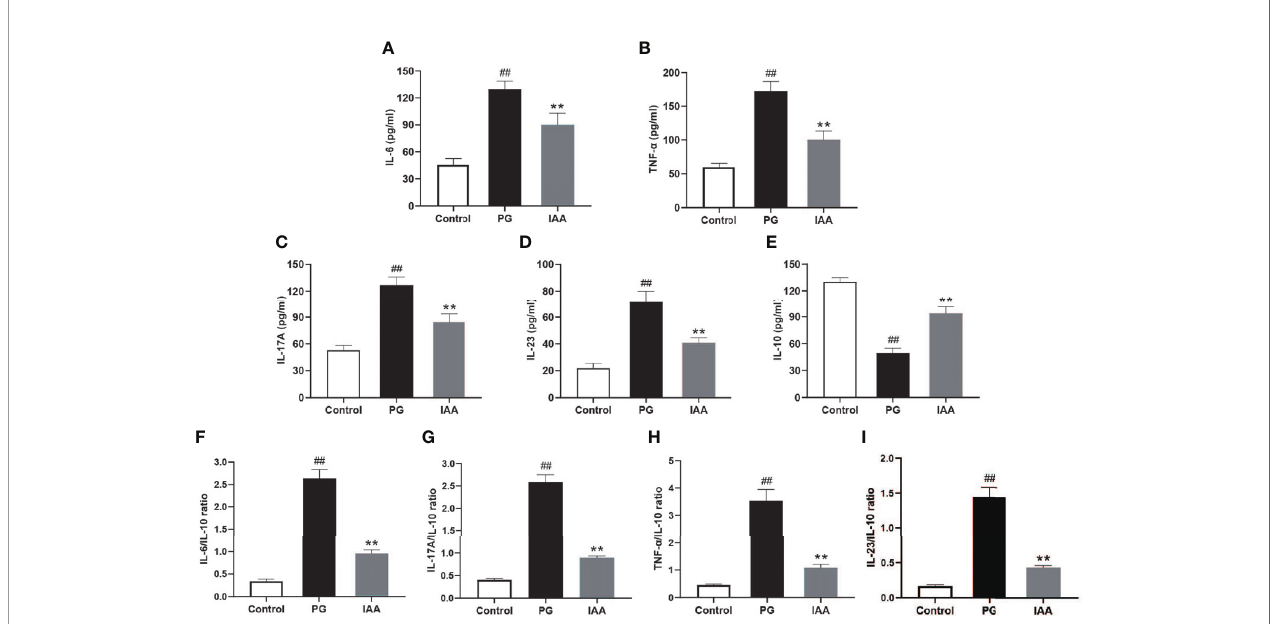
FIGURE 2 | IAA inhibits pro-in fl ammatory cytokines expressions, elevates anti-in fl ammatory cytokine expression, and reduces the ratios of pro-/anti- in fl ammatory cytokines in AS mice. Ankylosing spondylitis (AS) mice were administered intraperitoneal injections of indole-3 acetic acid (IAA; 50 mg/kg/day) for 4 weeks. The serum levels of the pro-in fl ammatory cytokines interleukin (IL)-6, tumor necrosis factor (TNF)- a , IL-17A, and IL-23, and the anti-in fl ammatory cytokine IL-10 were detected by enzyme-linked immunosorbent assay (ELISA). (A) IL-6, (B) TNF- a , (C) IL-17A, (D) IL-23, (E) IL-10, (F) IL-6/IL-10, (G) IL-17A/IL-10, (H) TNF- a /IL-10, (I) IL-23/IL-10. (n = 6). Data are expressed as the mean ± standard deviation (SD); ## p < 0.01 vs. control; ** p < 0.01 vs. PG